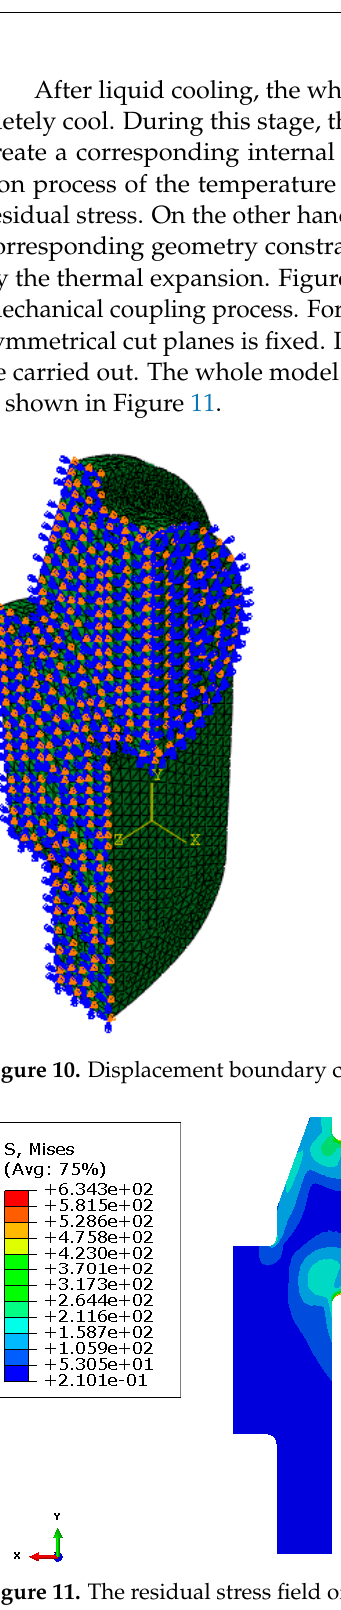
Figure 9. The temperature field after liquid cooling.